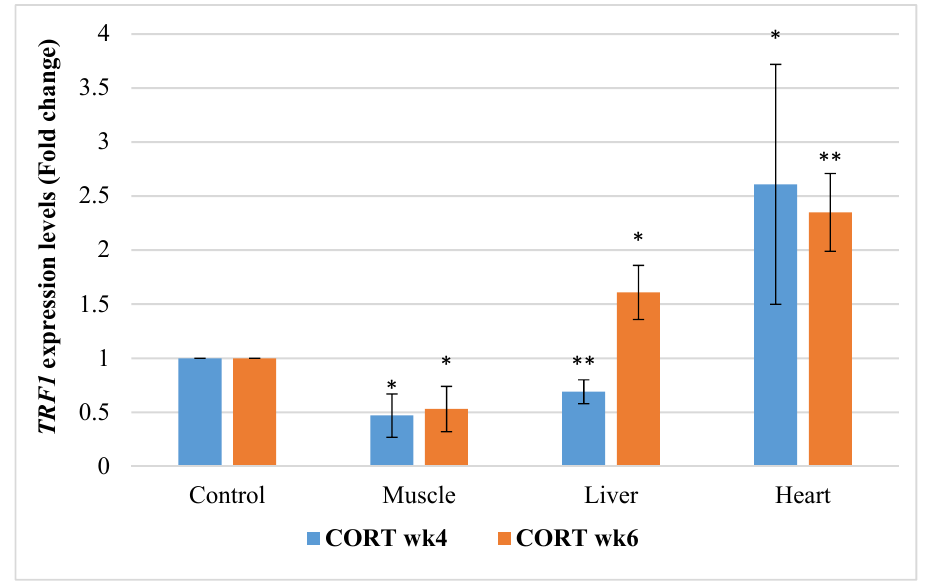
Figure 1. Expression profile of telomeric repeat transcription factor 1 ( TRF1 ) in the muscle, liver, and heart at week 4 and 6 of corticosterone-fed chickens compared to the control (in fold change). CORT wk4 = 4 weeks of age (2 weeks of CORT administration); CORT wk6 = 6 weeks of age (4 weeks of CORT administration); n = 20. Probability, * = p < 0.05; ** = p < 0.01.